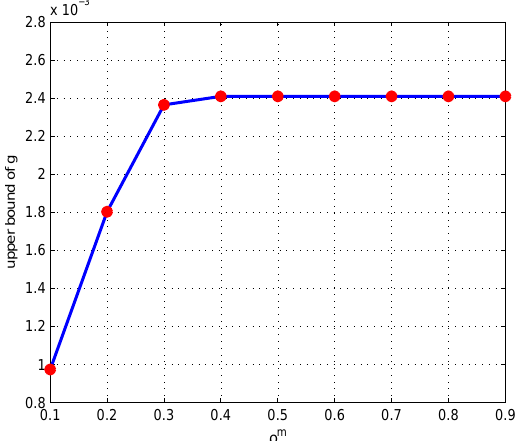
Figure 4. Upper bound of g for a fixed ρ m =